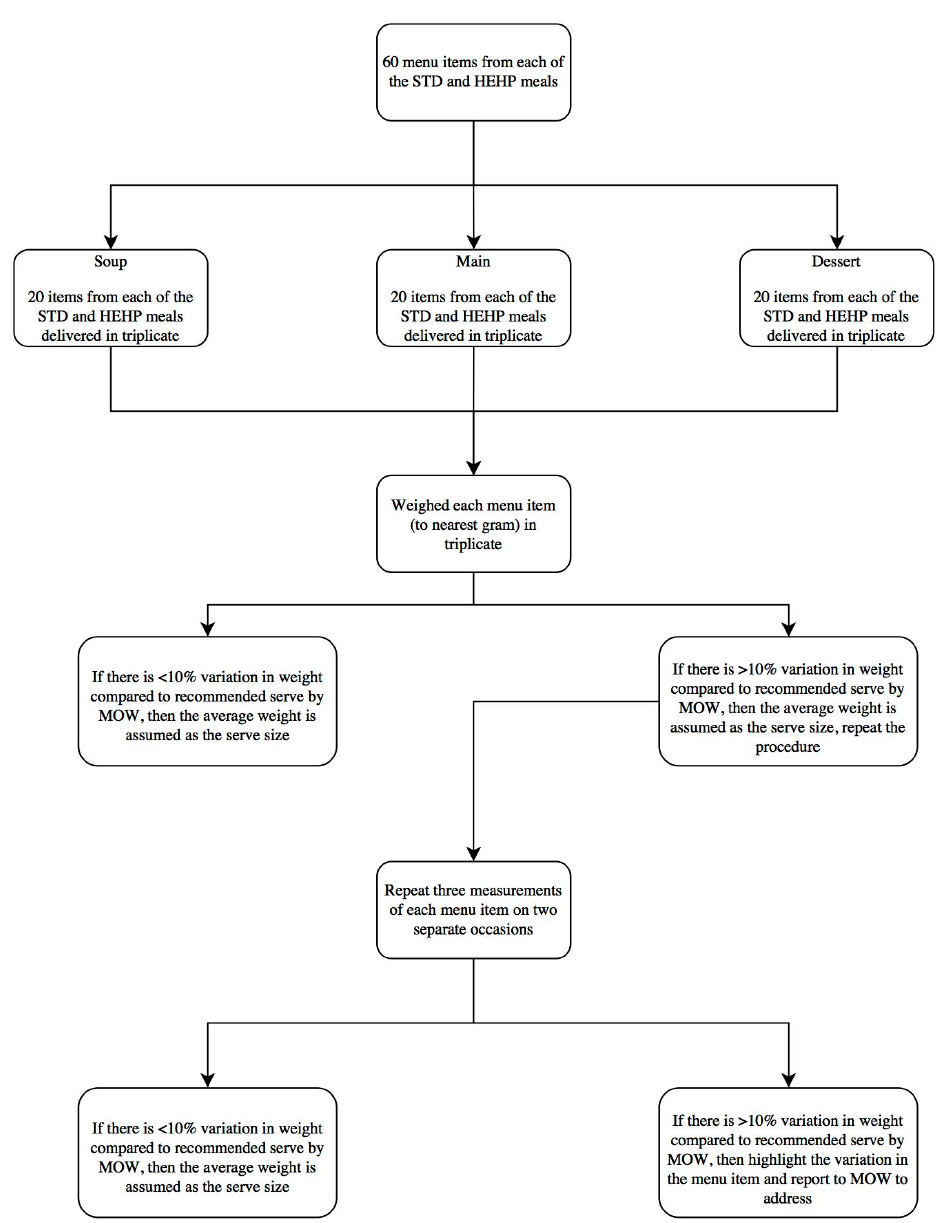
Figure 1. Meal audit process. STD: standard meals, HEHP: high energy and protein fortified meals; nutrient content was analyzed using FoodWorks 3.01. MOW: Meals on Wheels.